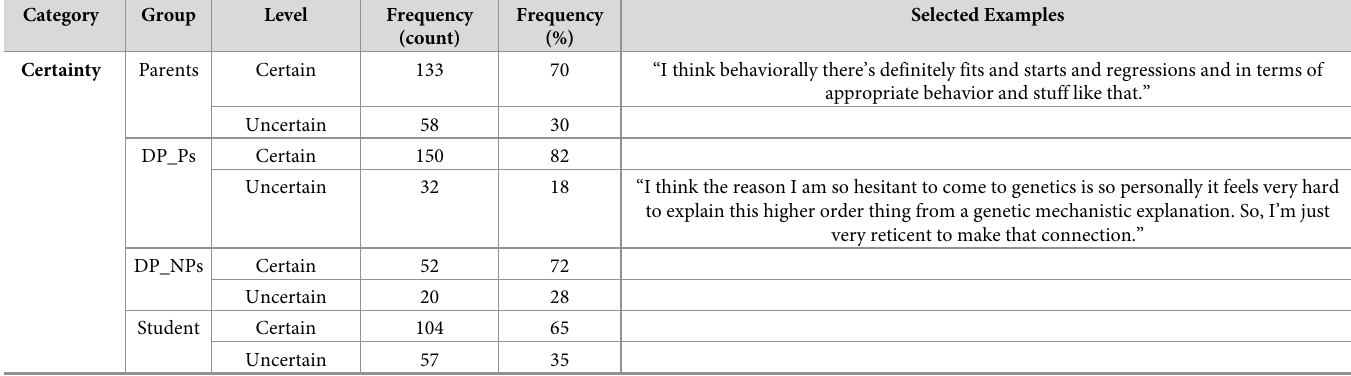
Table 3. Frequency of participant utterances for all